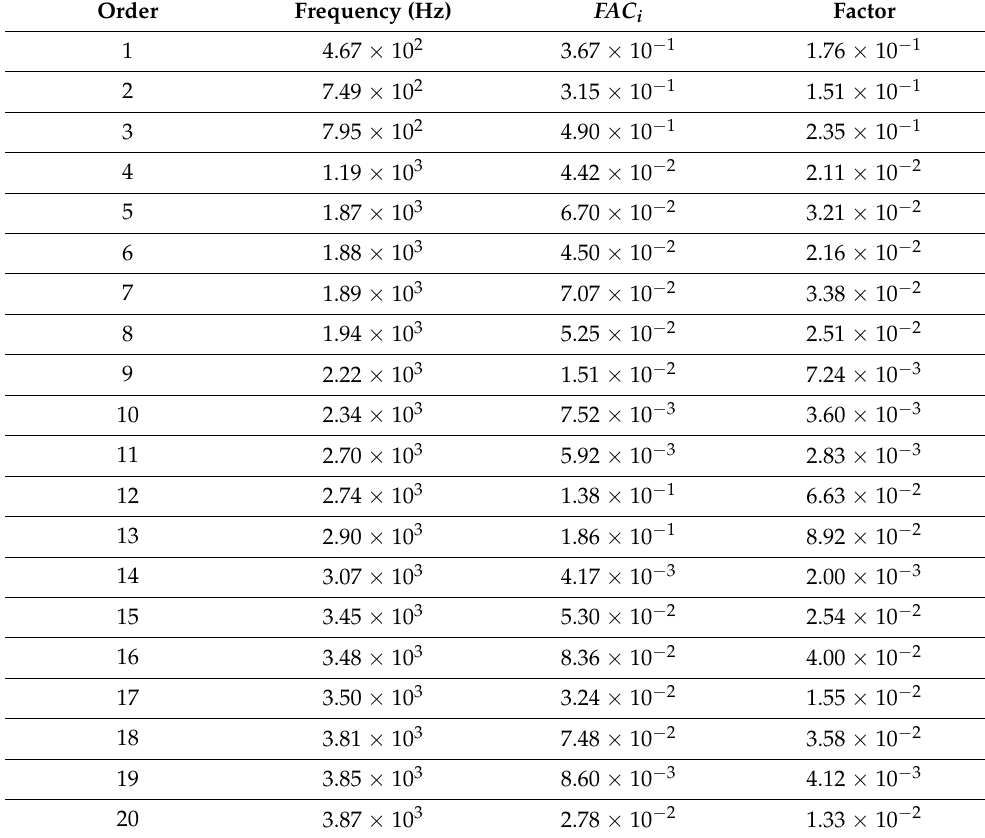
Table 2. Each order modal frequency, modal participation factor and weight coefficient.